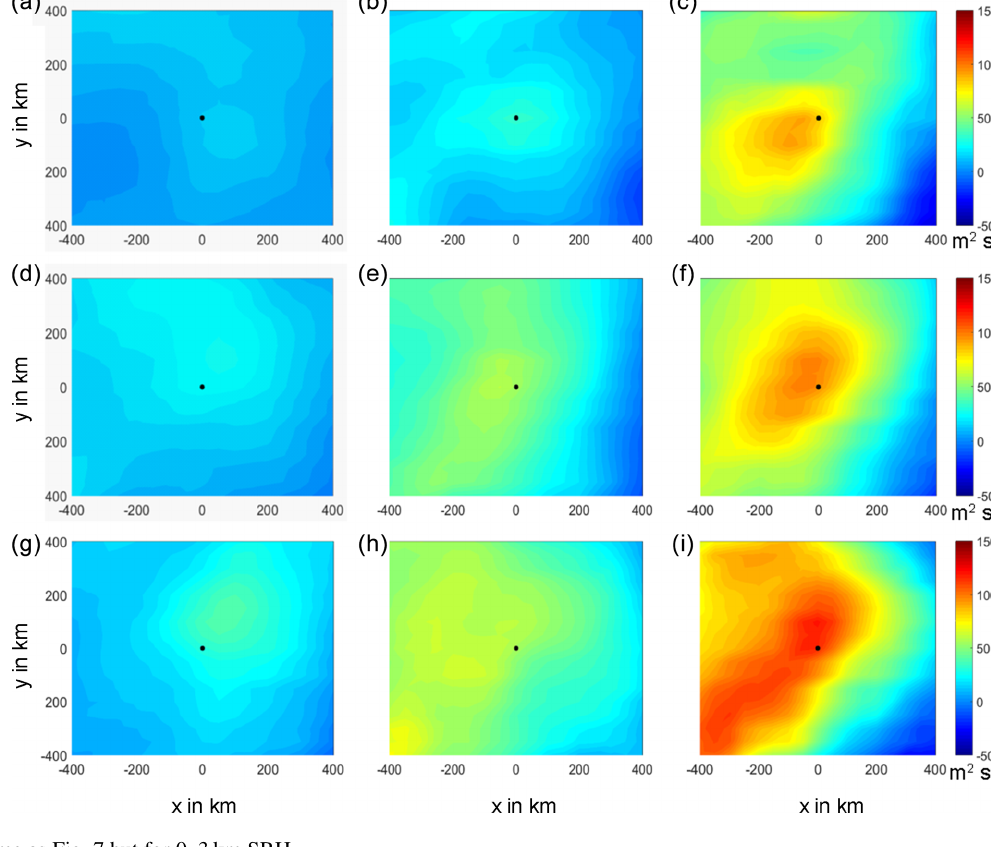
Figure 9. Same as Fig. 7 but for 0–3km SRH.